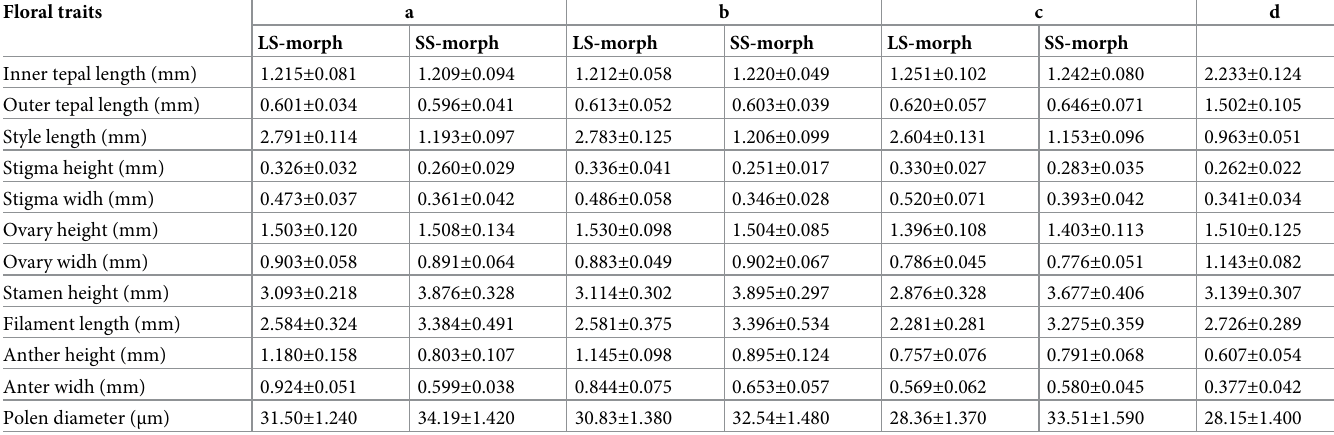
Table 1. Floral dimensions (mean ± standard deviation) of the long styled (LS) and short styled (SS) flowers of Polygonom L. species. a: P . equisetiforme var. graecum , b: P . equisetiforme var. peyerinhoffi , c: P . aviculare , d: P . maritimum .